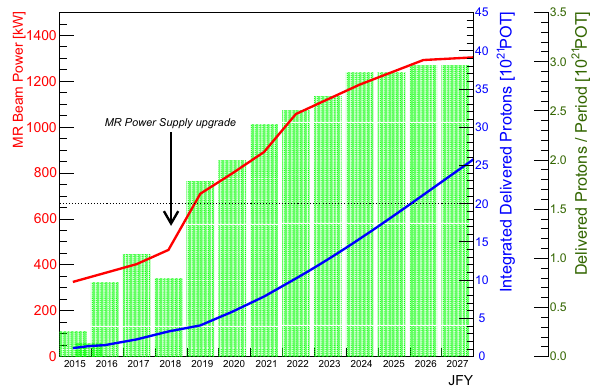
Fig. 76 Expected POT with an extension of T2K. [98]